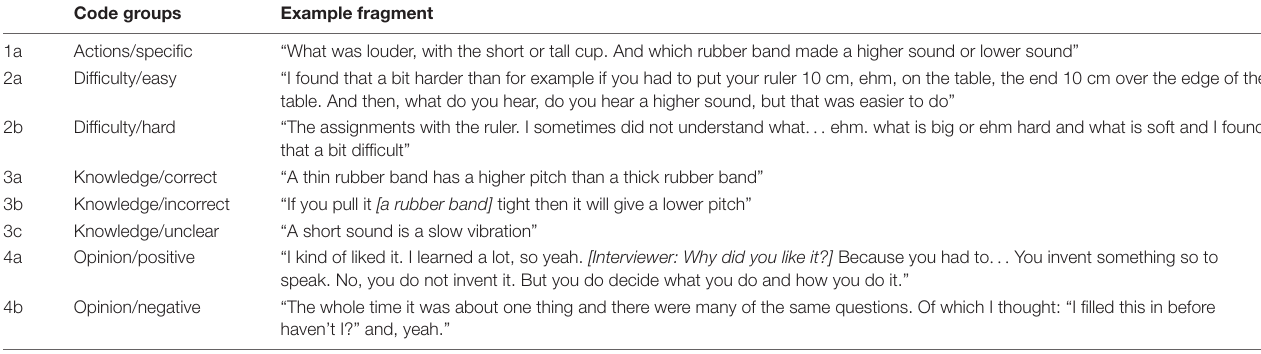
TABLE 2 | Detailed descriptions of the code groups for lesson 2 “experimenting”.